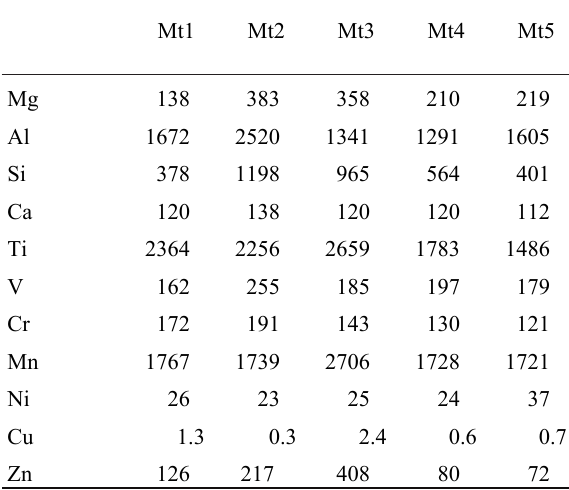
Table 6. LA­ICP­MS analyses of magnetites from the Jõhvi magnetite quartzites. Altogether 38 analyses were performed on five magnetite grains (Mt1–Mt5) from the polished section of drill core J­1 (depth 312.1 m). Average compositions of these grains are provided in the